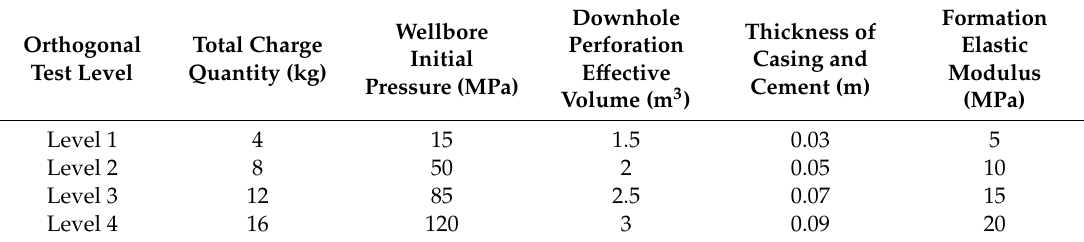
Table 6. Orthogonal test level